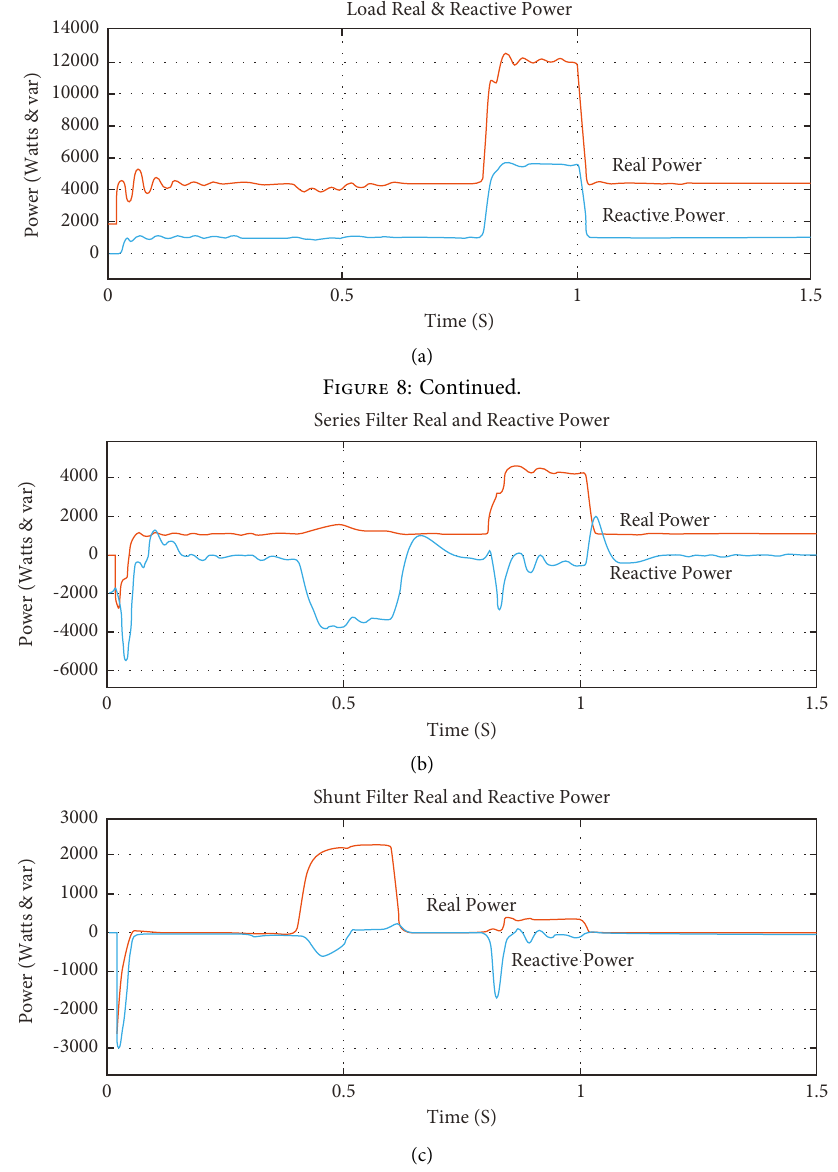
Figure 8: (a) Load side real and reactive power, (b)power absorbed by the series converter, and (c)injected shunt converter